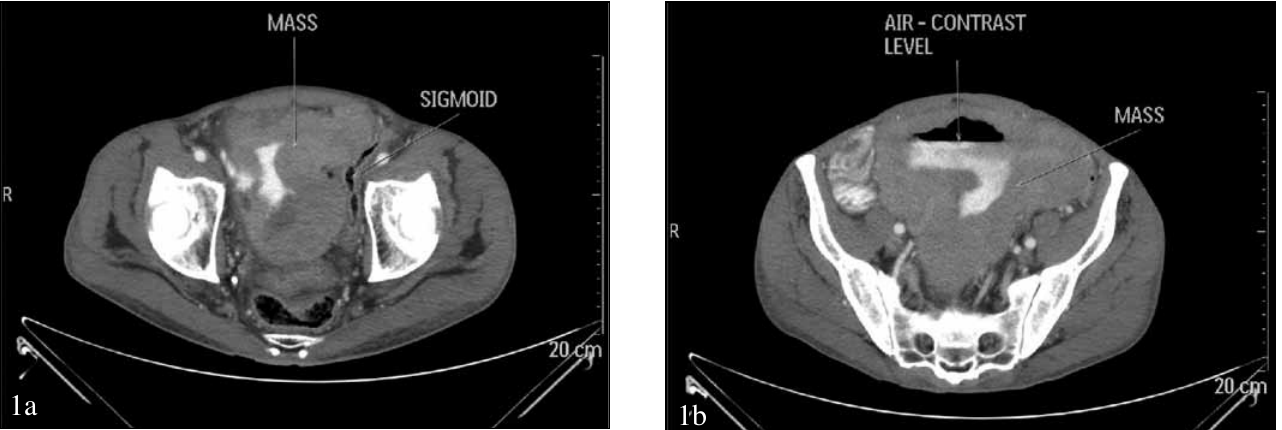
Fig. 1. Axial post-contrast CT, venous phase at the level of the pelvis, showing a large mass with central ulceration as well as contrast collection (1a) and an air fluid level